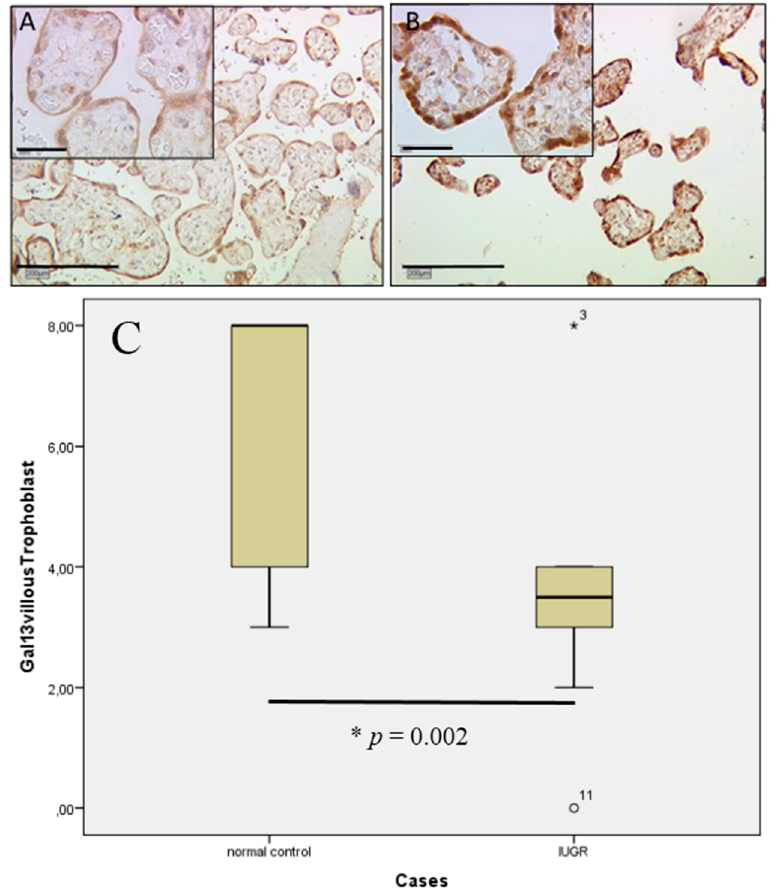
Figure 5. In villous trophoblast gal-13 expression is down regulated in cases of IUGR ( A ) compared to control placentas with high expression of gal-13 ( B ); The results in staining intensity are statistically significant (* p = 0.002) as shown in the Box-plot ( C ). For details of Box-plot interpretation see legend of Figure 2, and the asterisk indicates values more than 3.0 box lengths from the 75th percentile.